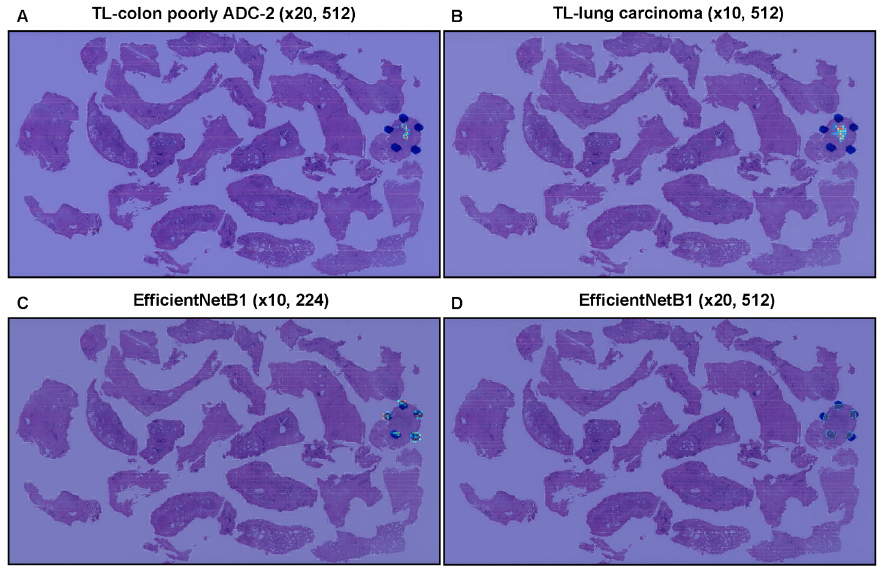
Figure 3. Comparison of adenocarcinoma predictions in the transurethral resection of the prostate (TUR-P) whole-slide image (WSI) of four trained deep learning models ( A – D ). In transfer learning (TL) models from colon poorly differentiated adenocarcinoma ( A ) and lung carcinoma ( B ), heatmap images show a true-postive prediction of adenocarcinoma where pathologists marked the surrounding with blue-dots. In EfficientNetB1 models ( C , D ), heatmap images show a false positive prediction of adenocarcinoma on the marked blue-dots. The heatmap uses the jet color map where blue indicates low probability and red indicates high probability. Table 5. Scores of accuracy, sensitivity, specificity, Negative Predictive Value (NPV), and Positive Predictive Value (PPV) on the transuretheral resection of the prostate (TUR-P), public dataset (TCGA), and needle biopsy test sets using the best model (TL-colon poorly ADC-2 ( × 20, 512)). Accuracy Sensitivity